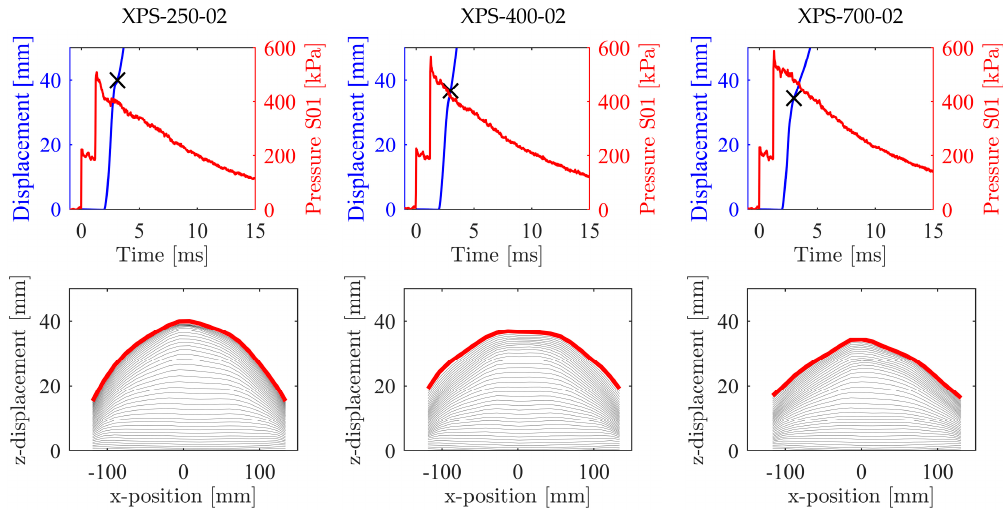
Figure A3. Displacement and pressure versus time (top) and displacement profiles (bottom) for tests on sandwich panels with 15 bar firing pressure, Series 2. Appl. Sci. 2020 , 10 , x FOR PEER REVIEW